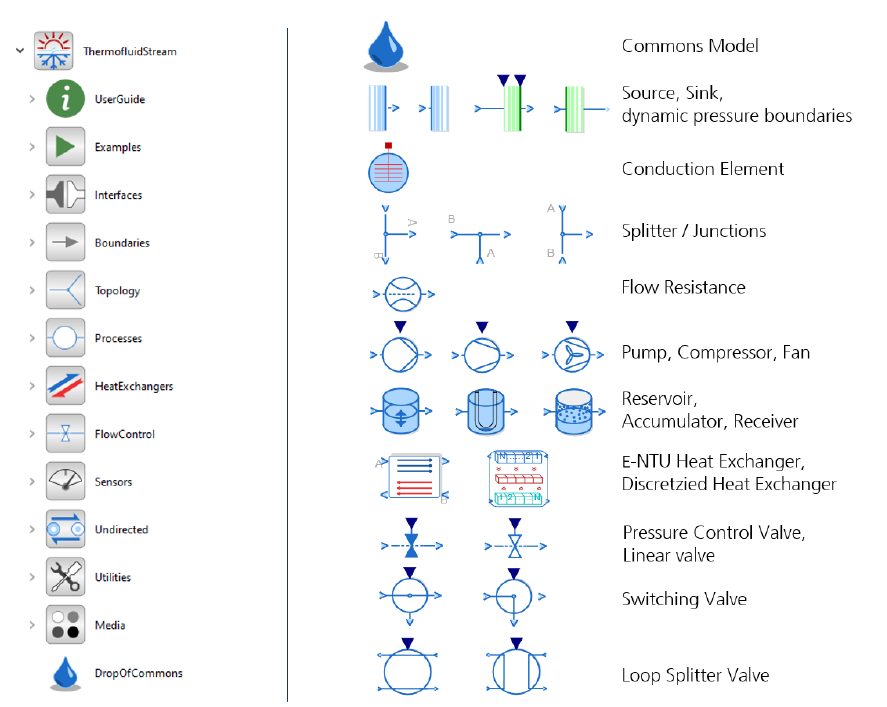
Figure 2. Overview of the library and its main packages on the left side and key components on the right